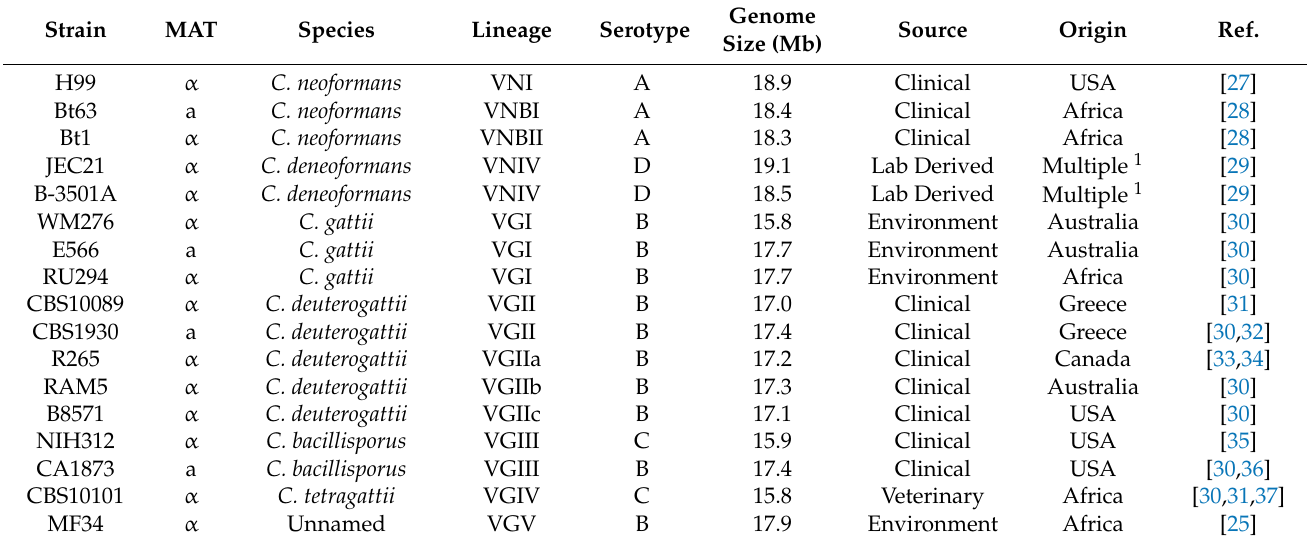
Table 1. Genome Diversity in Cryptococcus neoformans and Cryptococcus gattii